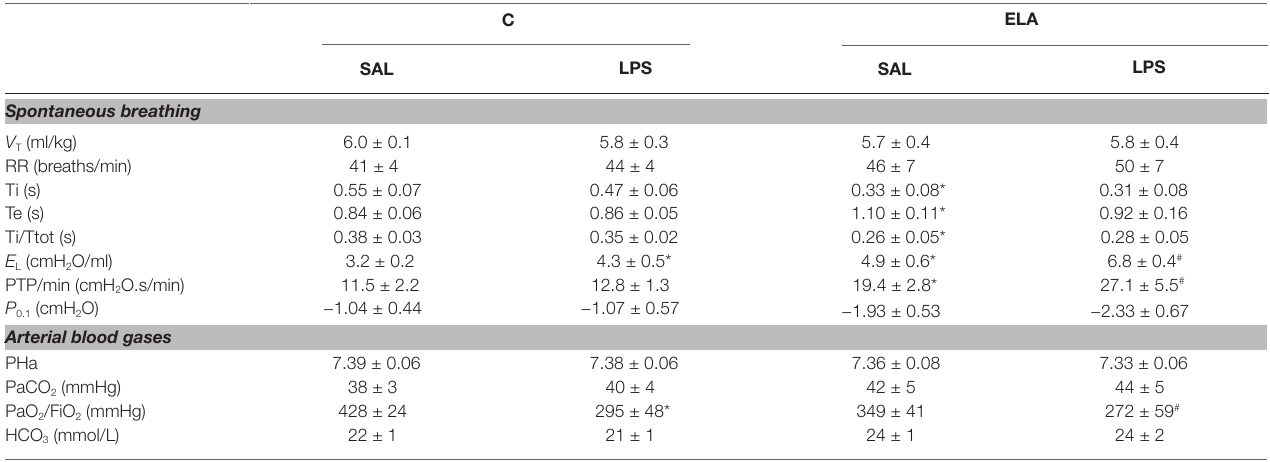
TABLE 1 | Respiratory mechanics and arterial blood gases.